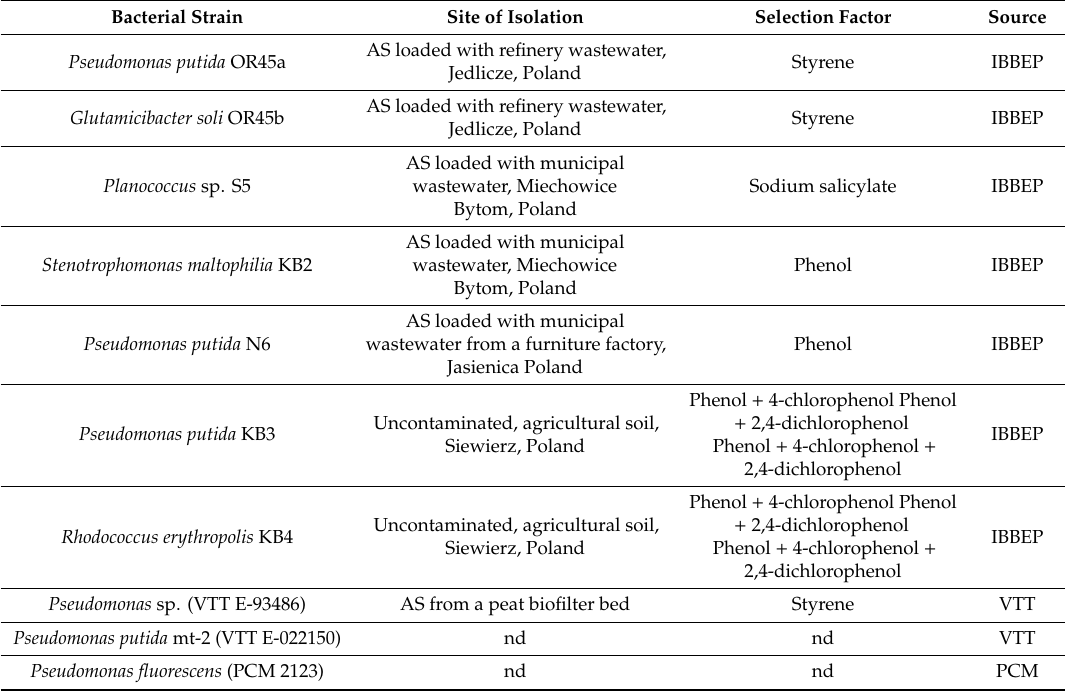
Table 1. Microorganisms selected for bioaugmentation of the activated sludge (AS) in the combined treatment of municipal wastewater and landfill